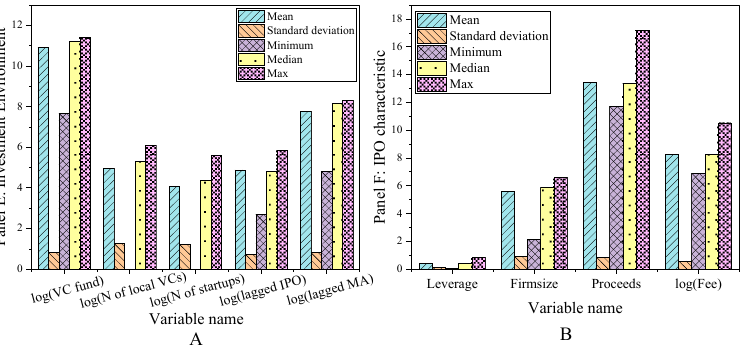
Figure 3. Descriptive statistical results of main variables in sample interval ( A ) Panel C; ( B ) Panel D. Figure 4. Descriptive statistical results of main variables in sample interval ( A ) Panel E; ( B ) Panel F.